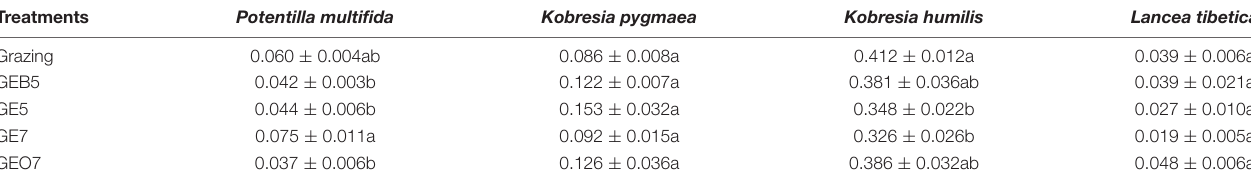
TABLE 5 | The change of the important value (IV) of keystone species among the grazing exclusion gradient. Treatments Potentilla multifida Kobresia pygmaea Kobresia humilis Lancea tibetica